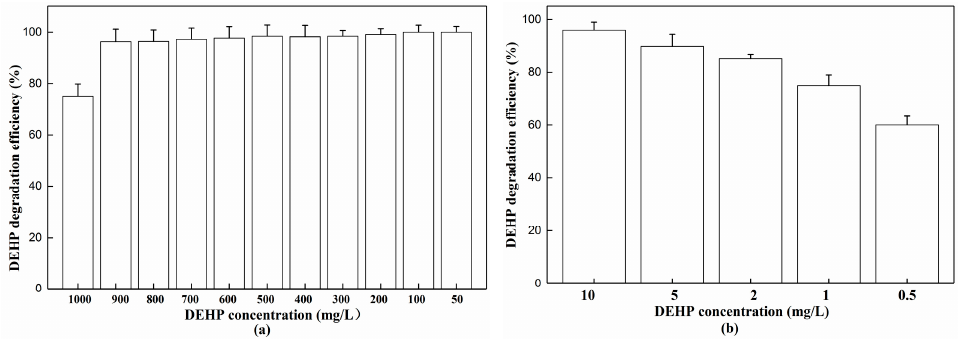
Figure 7. ( a ) Maximum and ( b ) minimum degrading ability of DEHP. The standard error of the mean of the three replicates is represented by the error bar.